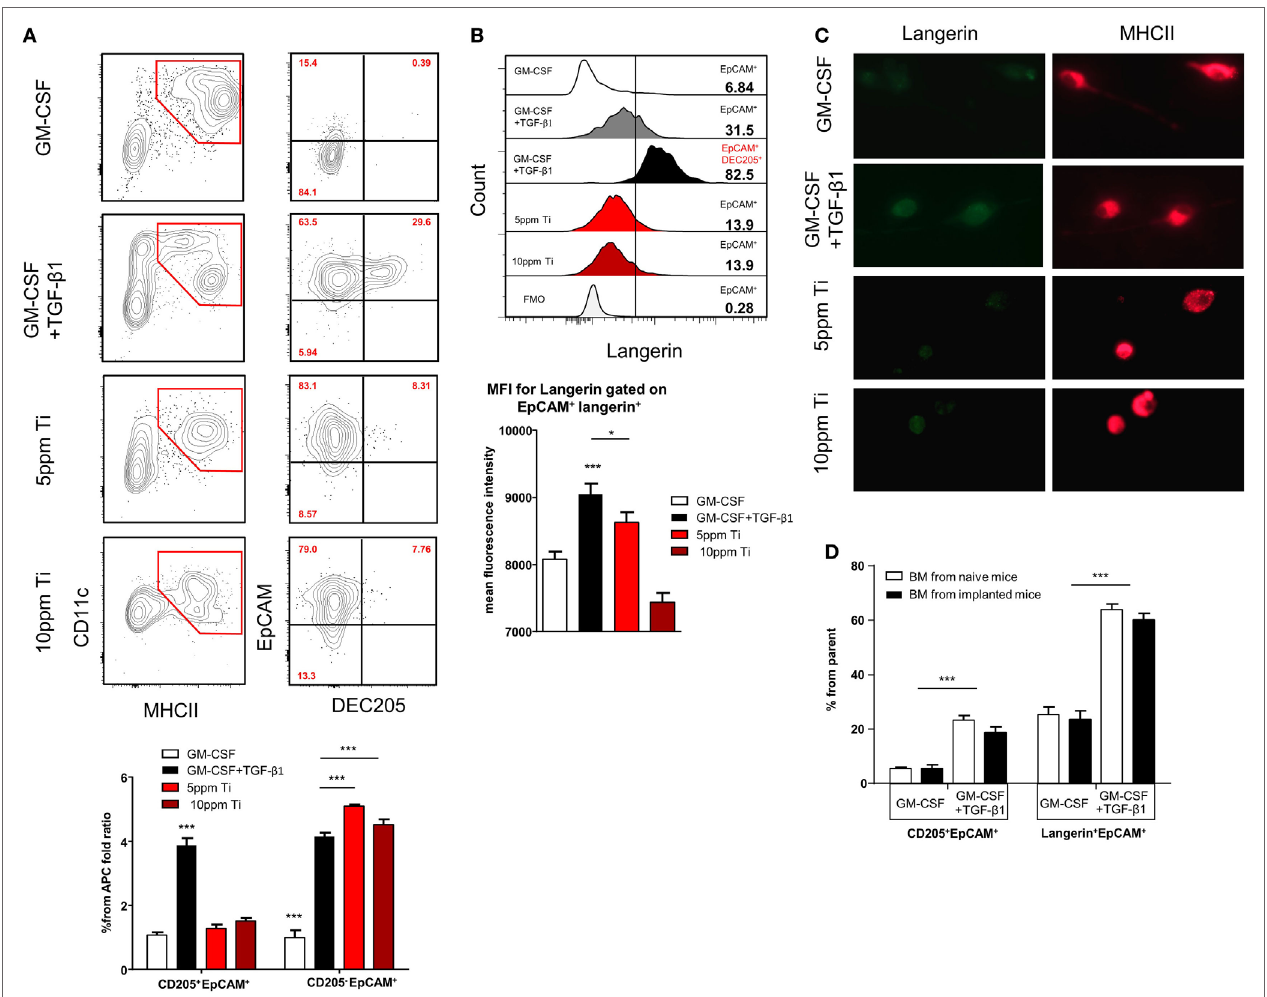
FigUre 5 | Titanium ions altered in vitro differentiation of Langerhans cell (LC)-like cells from BM precursors. (a) Frequencies of CD11c + MHCII + cells and LC-like cells (CD11c + MHCII + EpCAM + DEC205 + ) 5 days after incubation with GM-CSF or TGF- β 1 + GM-CSF in the presence or absence of 5 and 10 ppm of Ti ions. Representative FACS plots and graphs indicates the fold change in the percentage of EpCAM + DEC205 + (LC-like cells) and EpCAM + DEC205 neg cells from total CD11c + MHCII + population (percentages were normalized to the GM-CSF group) presented as the mean ± SEM ( n = 6 mice per group). Data are representative of one out of four independent experiments. (B) Representative histogram plots illustrate the frequencies of langerin expression on pre-gated EpCAM + and EpCAM + DEC205 + cells after 5 days of culture. Bar graph specifies the mean fluorescence intensity (MFI) of langerin expression on pre-gated cells shown as the mean ± SEM ( n = 6 mice per group). Data are representative of one out of two independent experiments. (c) Cells were collected from the LC differentiation cultures after 5 days and stained against langerin (green) and MHCII (red). Representative immunofluorescence images presenting the expression of langerin and MHCII in each culture condition. Data of one out two independent experiments are shown. (D) BM cells purified from implanted and non-implanted mice were cultured with GM-CSF or GM-CSF + TGF- β 1 and 5 days later were analyzed by flow cytometry. Bar graph presents the frequencies of LCs-like cells based on the expression of EpCAM, DEC205 an langerin from the CD11c + MHCII + cells representing the mean ± SEM ( n = 3 mice per group). Data are representative of one out of two independent experiments * p < 0.05, *** p <